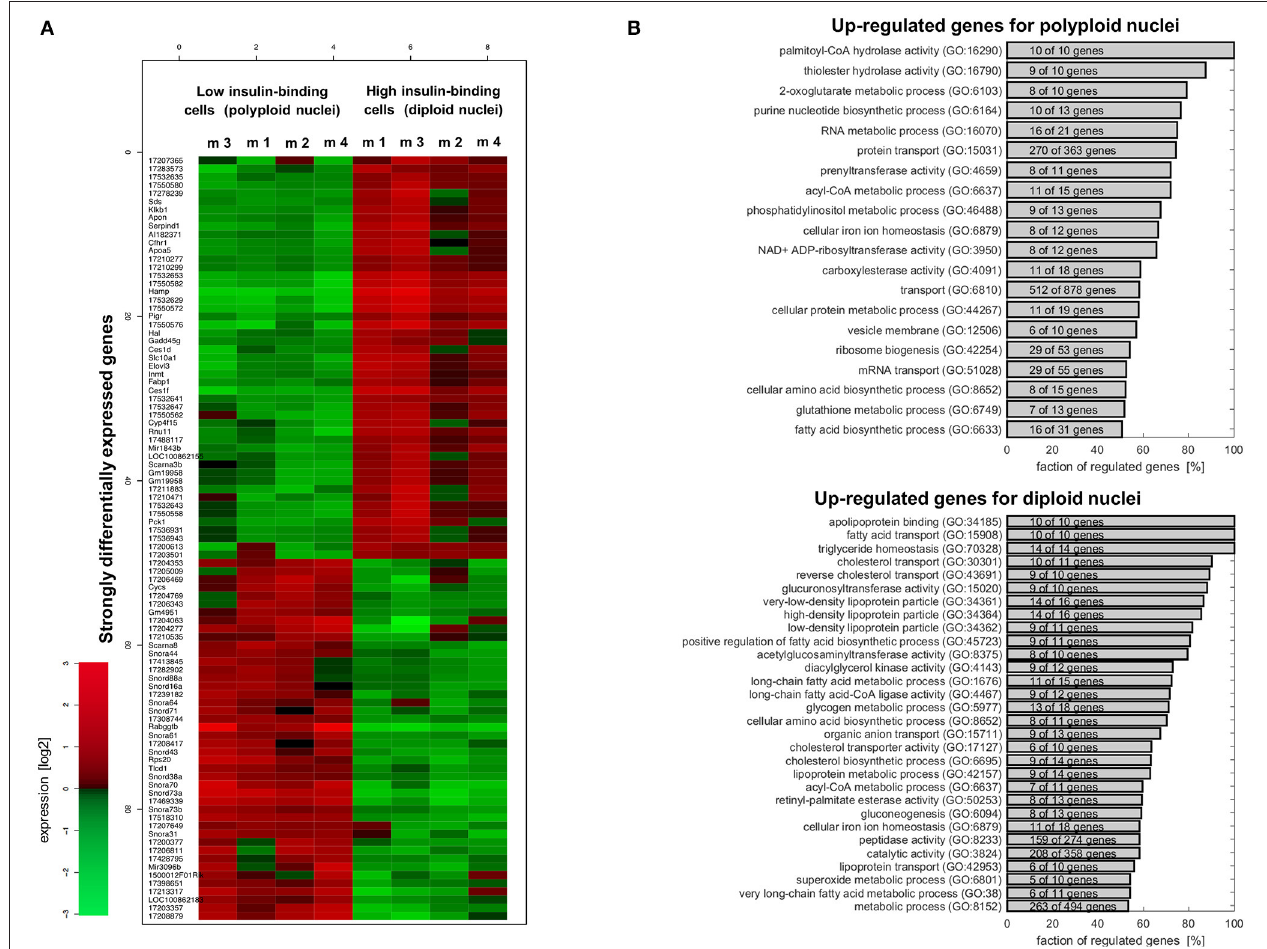
FIGURE 9 | Microarray analysis reveals major differences at the transcriptional level between hepatocytes having diploid or polyploid nuclei. (A) Heatmap for differentially regulated genes ( p < 0.01 and fold-change > 2) in insulin high-binding (diploid nuclei) and low-binding (polyploid nuclei) hepatocytes. Supplementary Table 2 provides the list of all differentially expressed genes. (B) Functional analysis of the expression differences based on gene ontology categories performed by the Gene Set Regulation Index (Supplementary Material). The figure shows metabolic functions where at least 50% of genes are upregulated in polyploid (upper panel) and diploid (lower panel) hepatocytes. All the GO categories can be found in Supplementary Tables 3, 4. The corresponding figure for the signaling categories are provided as Supplementary Figures 4,